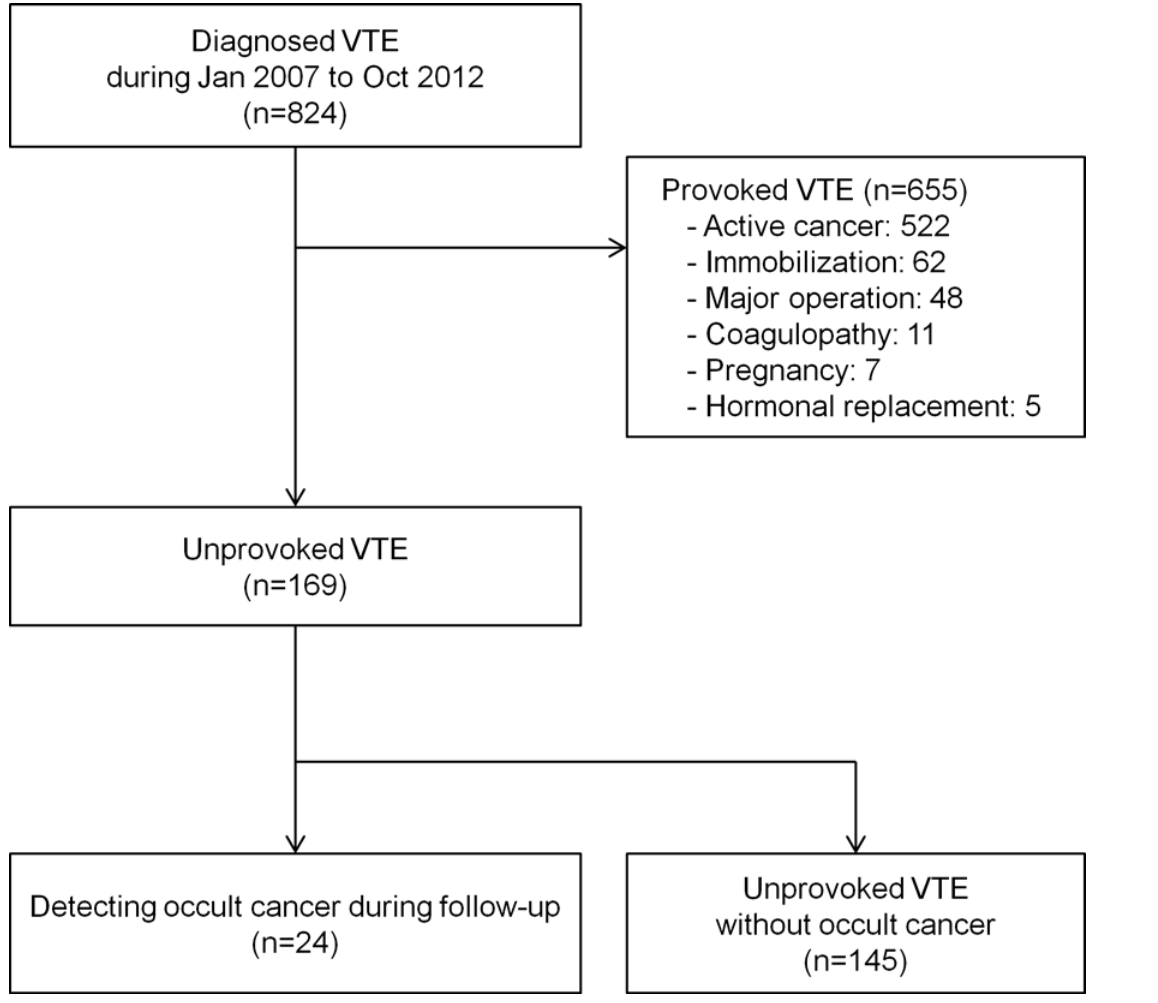
Fig 1. Flow chart of the study